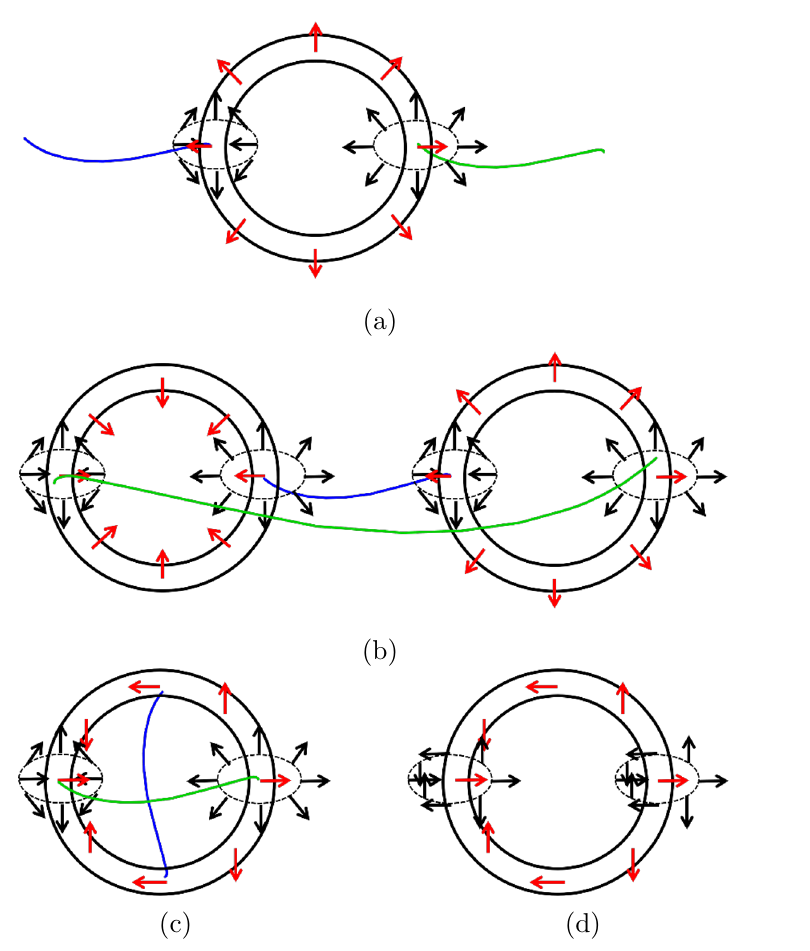
Figure 9 . Confined monopoles in the confined phase. (a) A monopole of the charge one is attached by an AB defect. (b) Two monopoles of the charge one are connected by an AB defect. (c) A doubly- twisted Alice ring as a monopole of the charge two. (d) A singly twisted double-winding Alice ring as a monopole of the charge